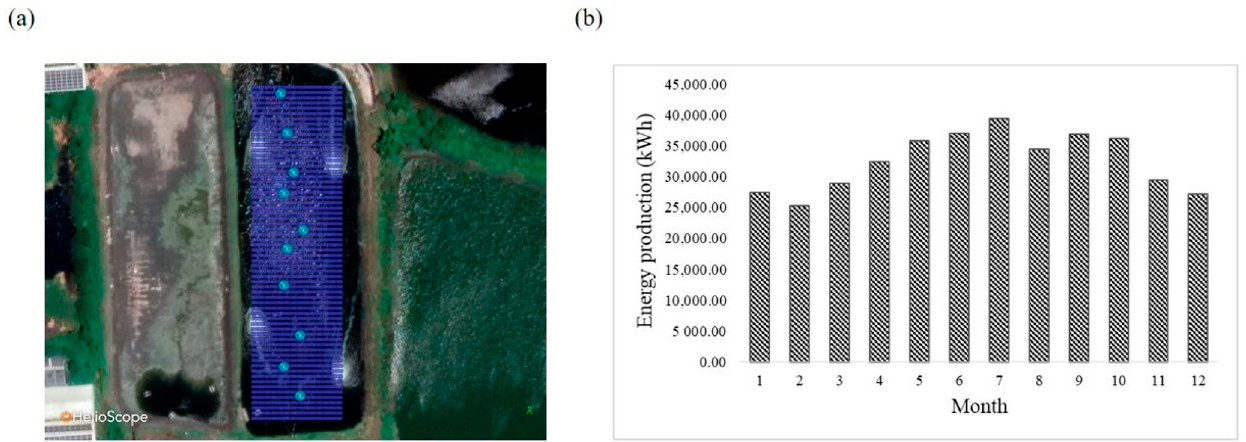
Figure 7. Mono-pitch farm canopy without shading effects at an optimum tilt of 10° ( a ) and the monthly energy production (kWh) of the study site ( b ).